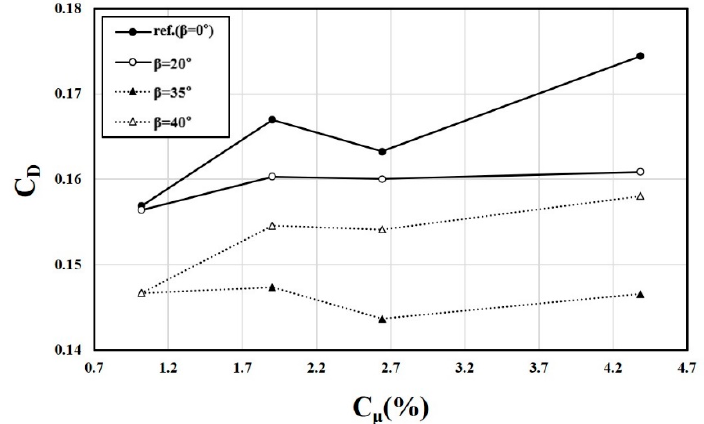
Figure 17. Variations of drag coefficient with momentum coefficient for various bending angles (x 0 /c = 0.7, α = 8 ◦ , δ f = 40 ◦